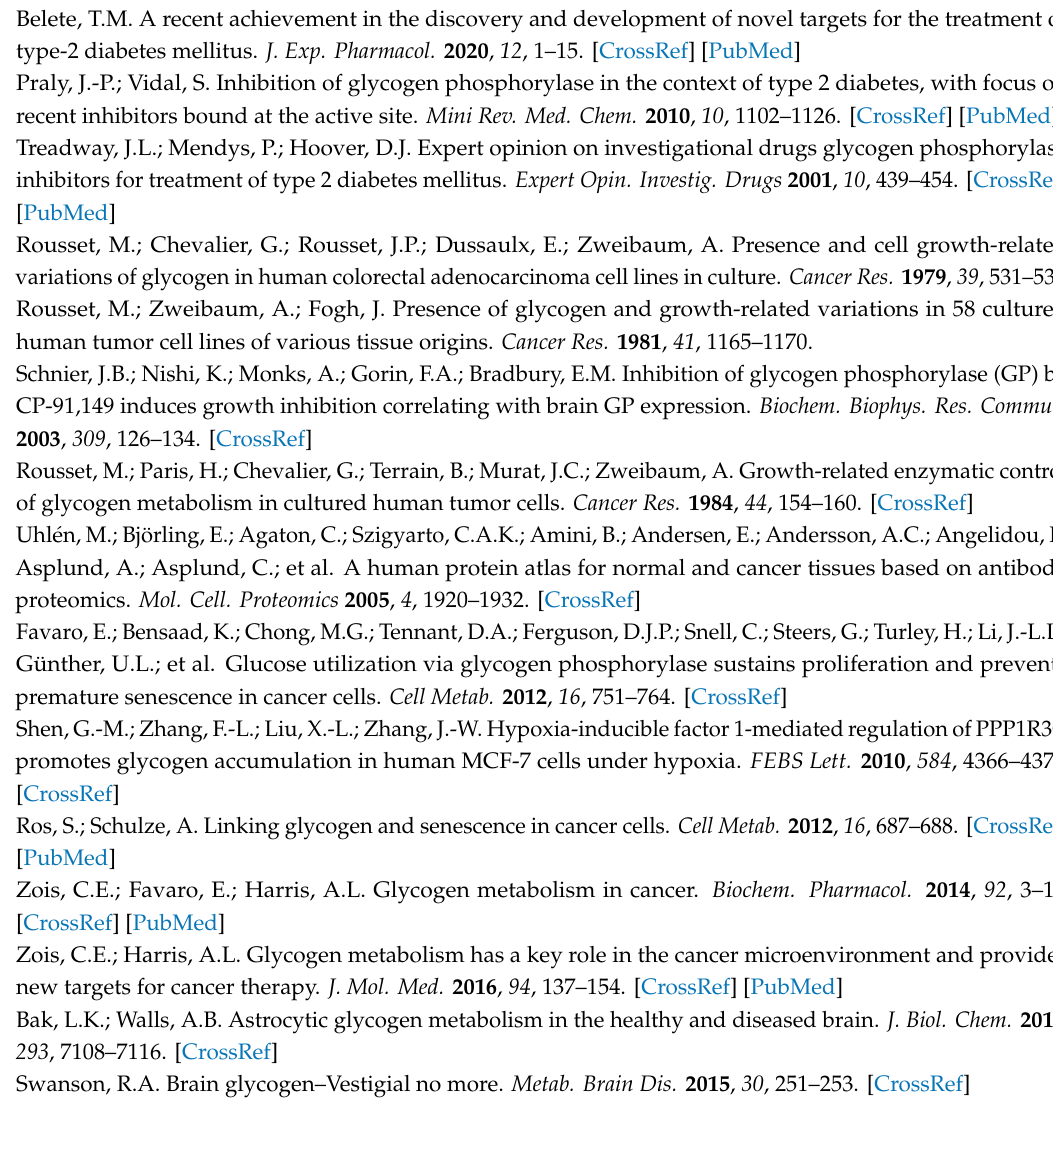
calculations (Tables S1 and S2) and kinetic study results for compounds 4 , 5 , 6 (Table